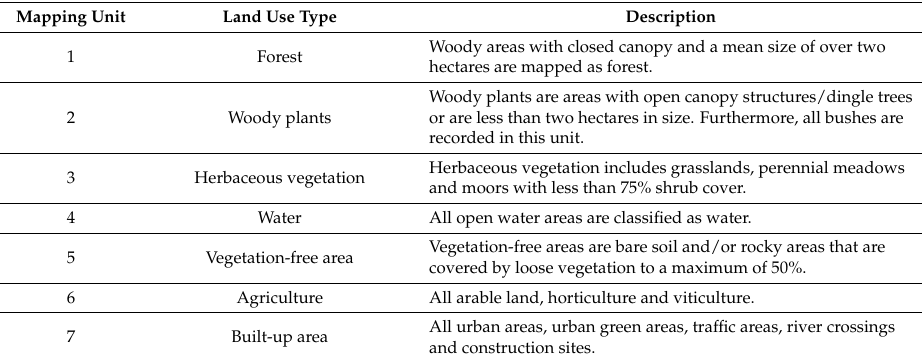
Table 3. The seven main mapping units of the regional biotope and land use data set